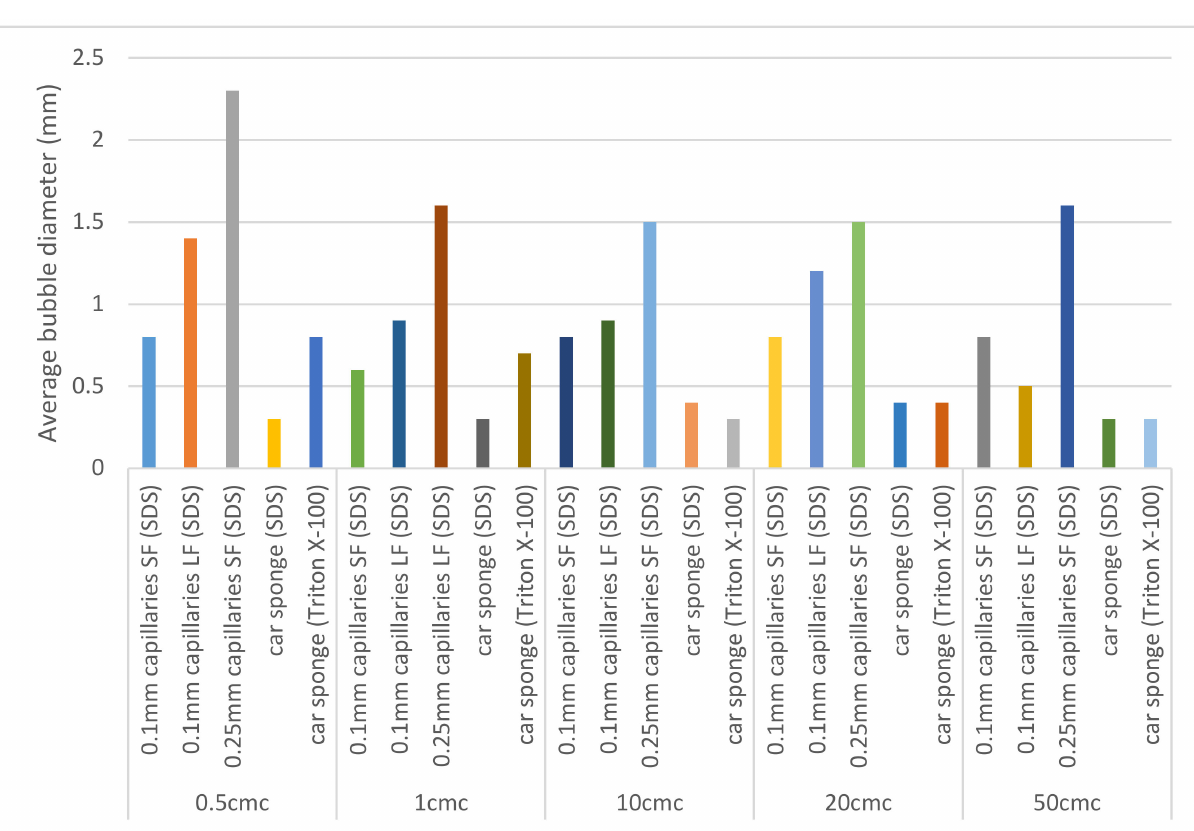
Figure 5. The average bubble diameters for each substrate and surfactant type for concentrations 0.5–50 CMC, where SF stands for small formation and LF stands for large